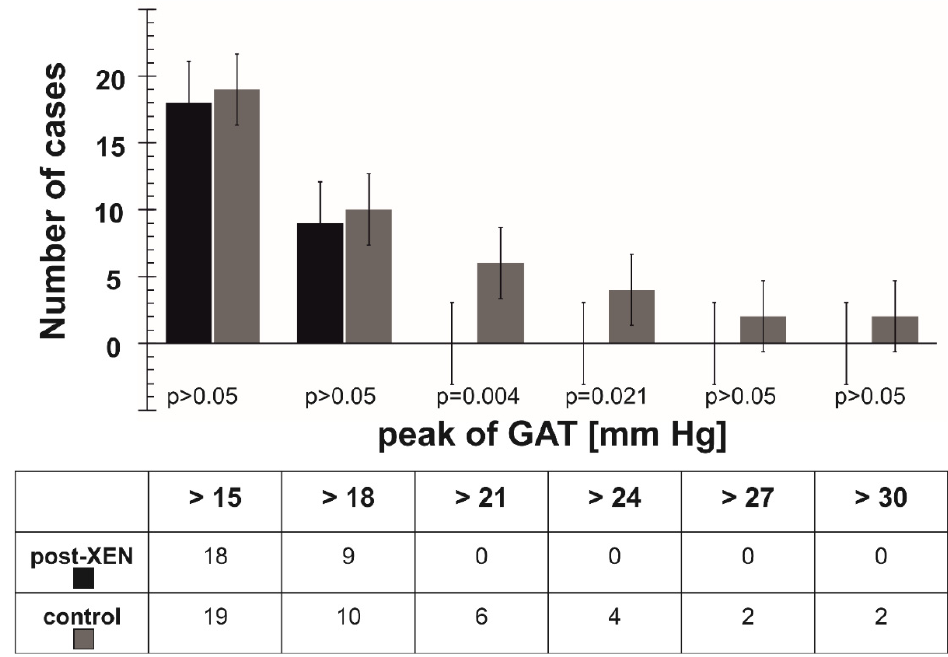
Figure 3. Comparison of the categorized GAT peak between the post-XEN and control groups (number of cases), Fisher’s exact test. Table 3. Summary of WDT results in the post-XEN and control groups.